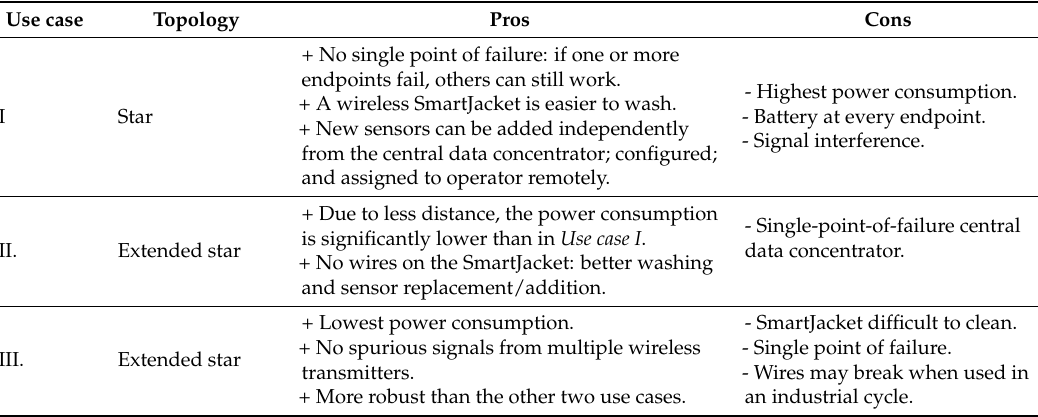
Table 4. A comparison of the use cases.